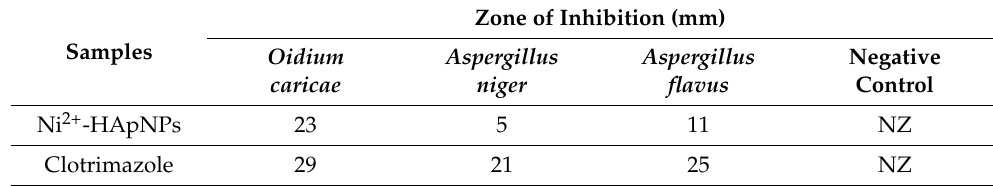
Figure 9. Antifungal activity of Ni 2+ -doped HApNPs treated against ( a ) O. caricae , ( b ) A. niger and ( c ) A. flavus.